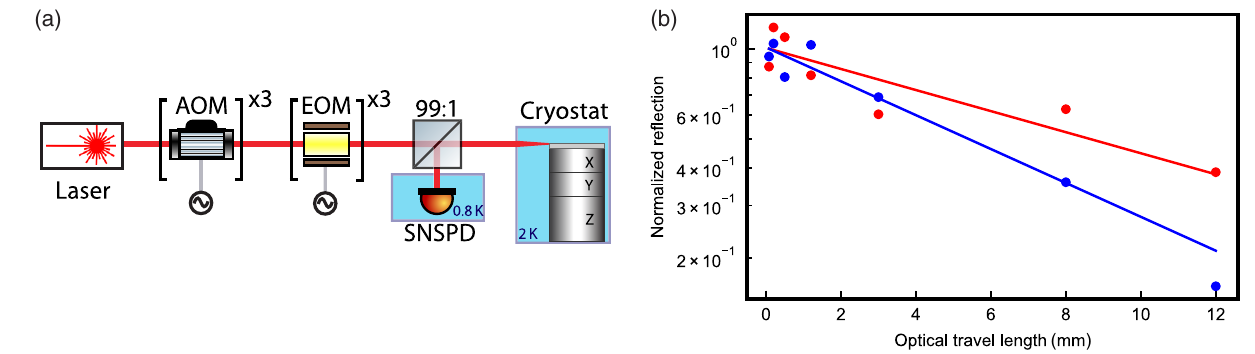
FIG. 7. (a) Experimental setup. AOMs are used to generate pulses of controlled duration, amplitude, and frequency shift from a continuous-wave laser. EOM, driven by an arbitrary-waveform-generator (AWG), are used to generate optical sidebands. A fiber-based nonpolarizing beam splitter with a 99 ∶ 1 (in some measurements 95 ∶ 5 ) split ratio is used to irradiate the excitation light and guide the fluorescence signal to a SNSPD. The sample is kept in a closed-cycle cryostat on an XYZ nanopositioning stage. (b) Waveguide propagation loss on the CVD samples. The reflected signal is measured for waveguides of different lengths. An exponential fit then allows for extracting the propagation loss for doped (blue) and undoped (red) CVD